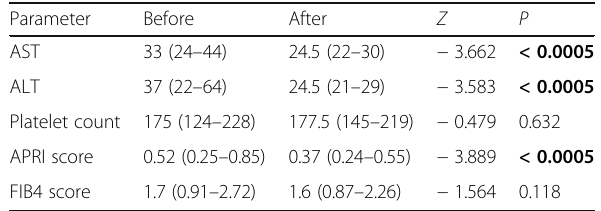
Table 5 Laboratory data before and after treatment: it showed a statistically significant improvement (decrease) in AST, ALT, and APRI score, but no statistically significant change in platelet count and FIB4 score Parameter